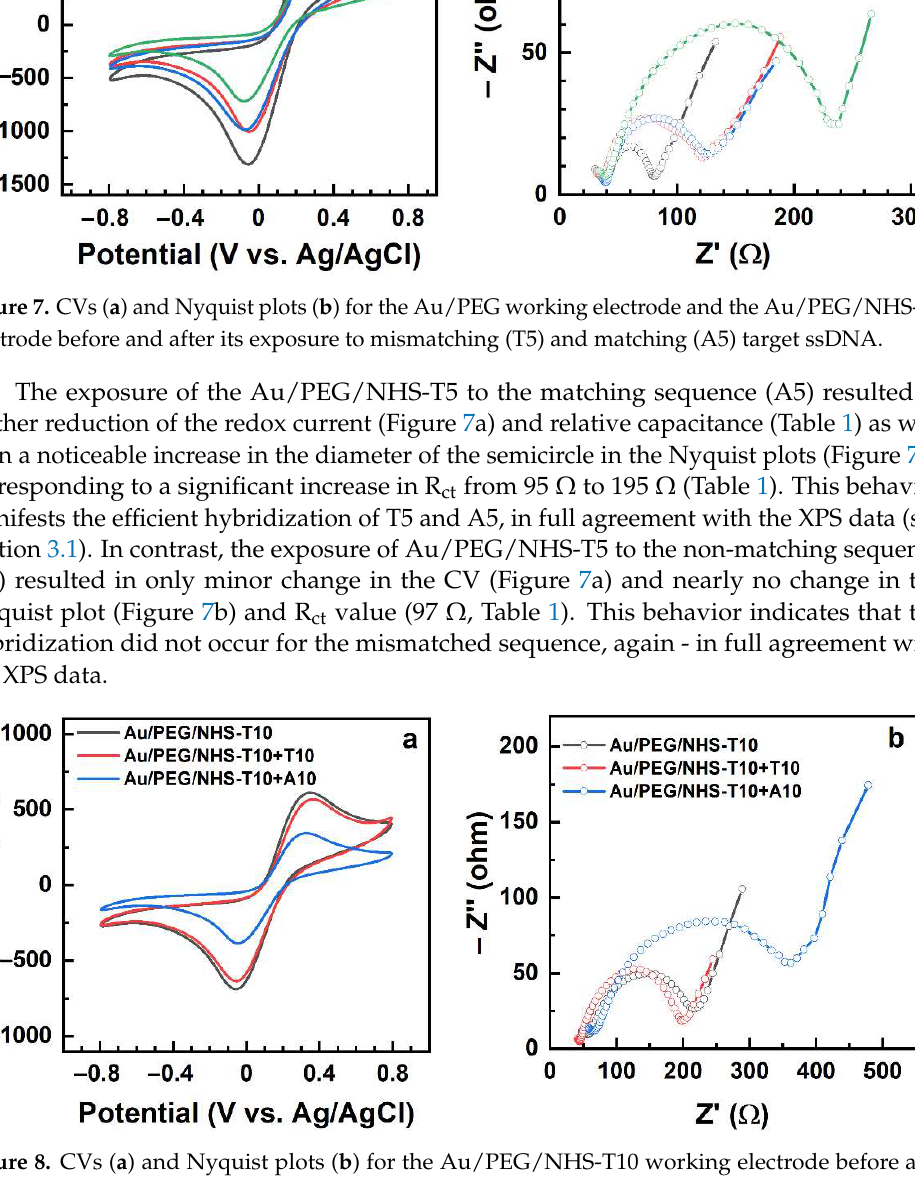
Figure 8. CVs ( a ) and Nyquist plots ( b ) for the Au/PEG/NHS-T10 working electrode before and after its exposure to mismatching (T10) and matching (A10) target ssDNA. Comparing the values for the NHS-T5 case with those for the NHS-T10 case in Table 1, viz. PEG/NHS-T5 vs PEG/NHS-T10 and PEG/NHS-T5+A5 vs PEG/NHS-T10+A10, we find that both the relative capacitance and R ct do not reproduce exactly the factor of 2 describing the base number difference between T5/A5 and T10/A10. The observed rela- tions can, on the one hand, be affected by the contributions from the PEG matrix and, on the other hand, reflect the somewhat different areal densities of the immobilized T5 and T10 moieties in the matrix. In contrast, both in the NHS-T5 and NHS-T10 case, the values of R ct increase by a factor close to 2 after the hybridization with the matching A5 and A10 sequences, which means that R ct can be used as a tentative measure of hybridization efficiency. Generally, looking at the data in Figures 6–8, one can see that the Nyquist plots represent a much clearer and more distinct way to monitor the immobilization and hybridization processes in the PEG matrix than the CVs. Thus, EIS can be efficiently used as a transduction tech- nique for these processes. Finally, the sensitivity of this technique in the case of PEG/NHS-T10+A10 was tested. The concentration of A10 was varied from 10 M (the standard value in this study; see Section 2.3) to 0.1 M. The respective Nyquist plots are presented in Figure 9a and the derived values of R ct are shown in Figure 9b. Accordingly and as expected, the R ct value decreases progressively with the decreasing A10 concentration. This value is still noticea- bly higher than the reference value for PEG/NHS-T10 at 0.2 M and nearly equal to the reference value at 0.1 M. Consequently, the sensitivity of PEG/NHS-T10 to A10 is down to 0.1–0.2 M, which can be probably improved even further by increasing the porosity of the PEG matrix and the areal density of the primary T10 probes.